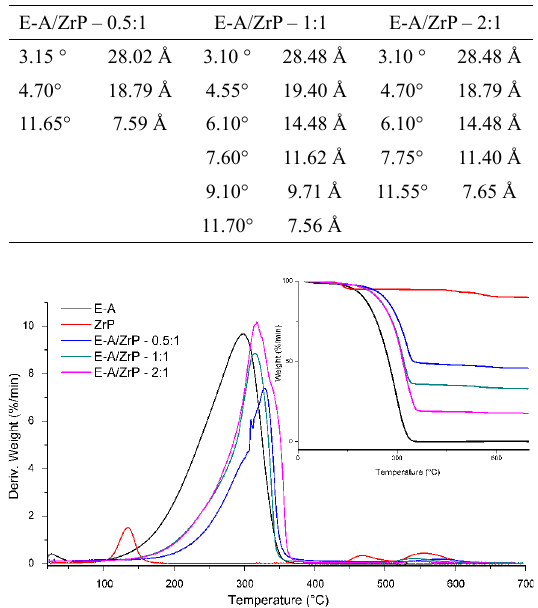
Table 2. Diffraction angles and dspacing of modified zirconium phosphate at different E-A/ZrP ratios.